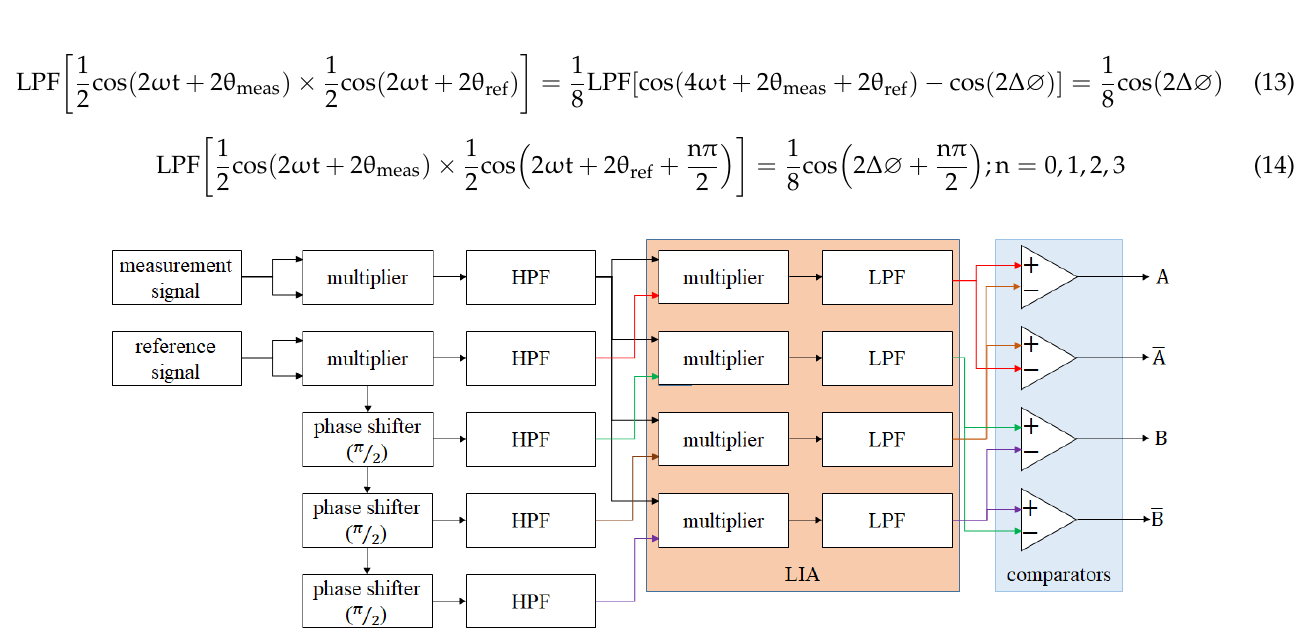
Figure 5. Block diagram of the first-order analog interpolator.